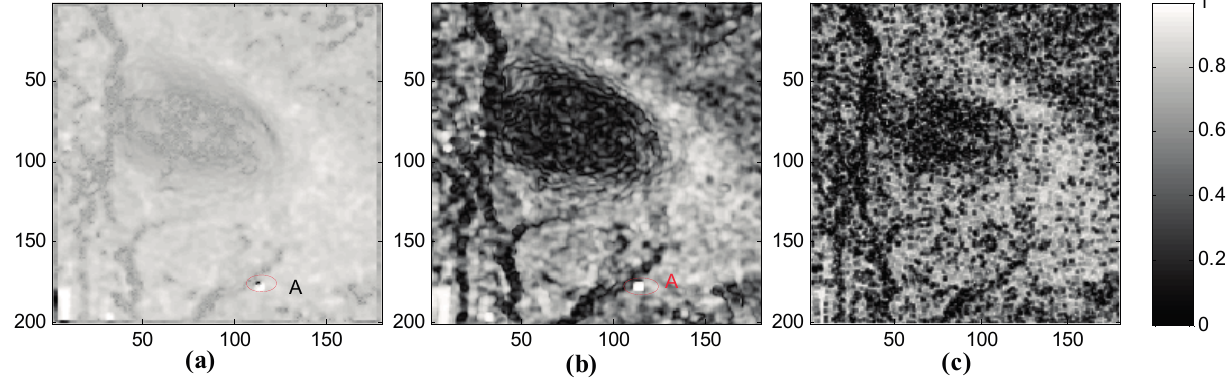
Figure 4. Three phase quality maps with FD, MC and PDV: ( a ) FD quality map; ( b ) MC quality map; ( c ) PDV quality